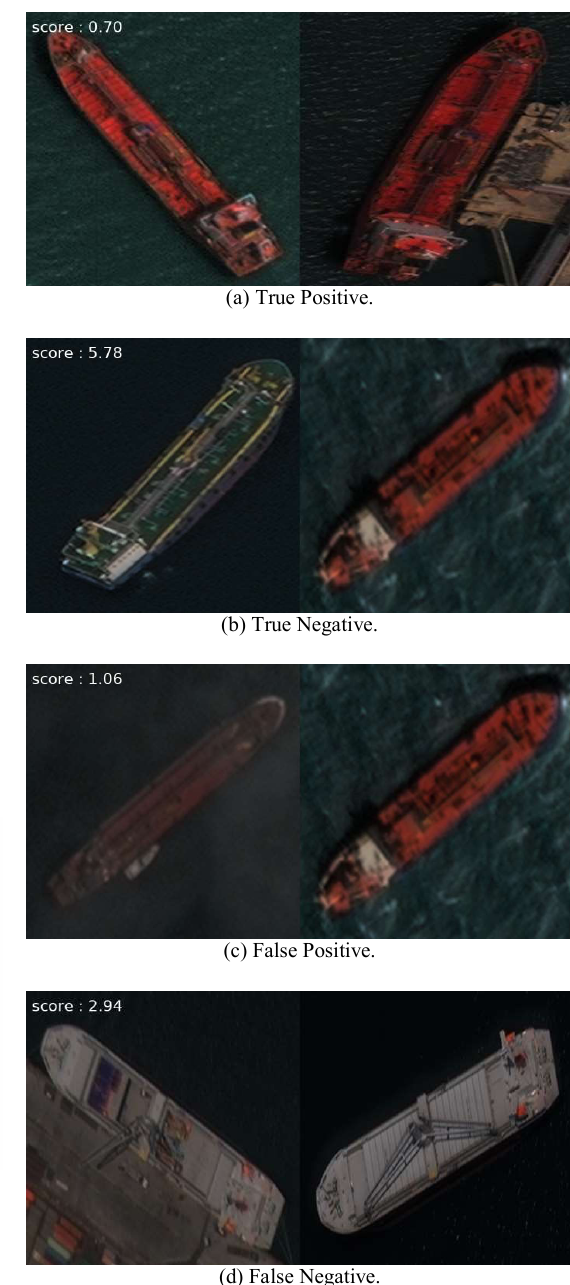
Figure 6(d) it failed to identify two images of the same vessel (False Negative, with a score of 2.94 close, yet not below the threshold of 2.5).